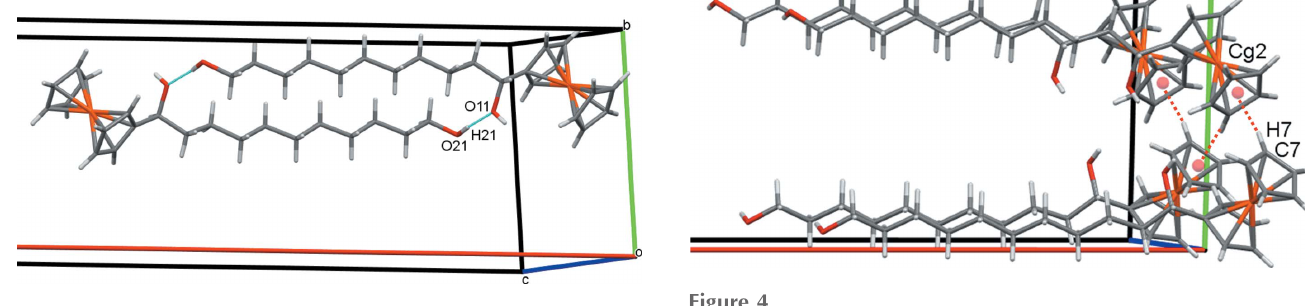
Figure 2 Inversion dimers of 1 in the ab plane with O—H (cid:2)(cid:2)(cid:2) O hydrogen bonds shown as blue lines.